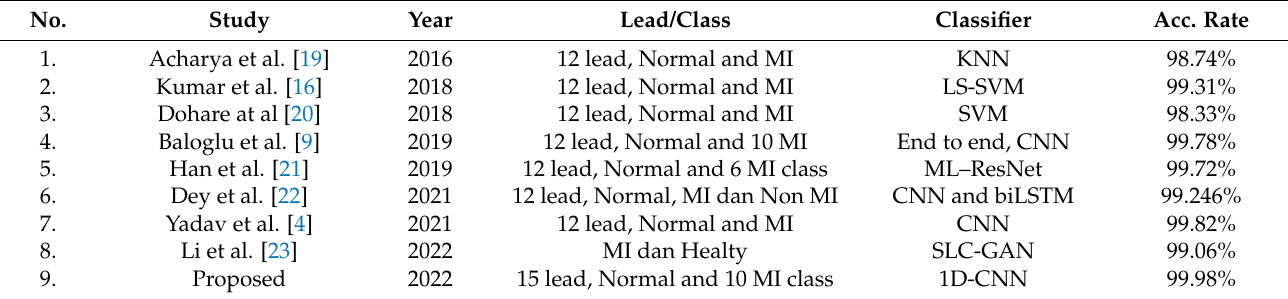
Table 6. Comparison of methods for detecting